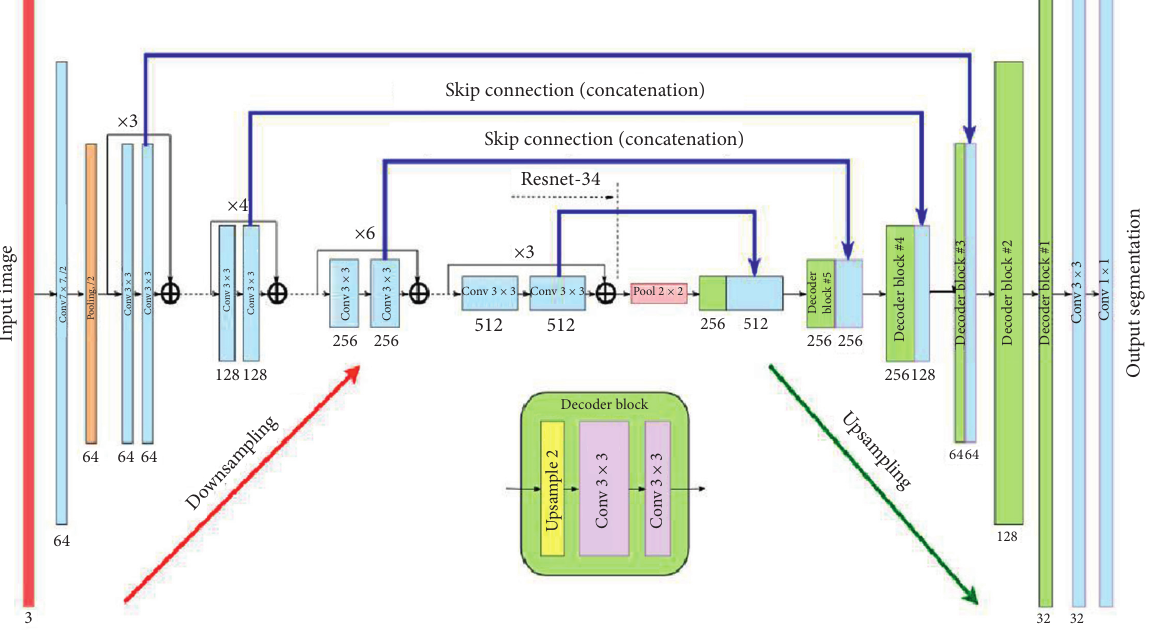
Figure 4: U-net architecture based on ResNet-34. Table 3: The architecture of U-net based on